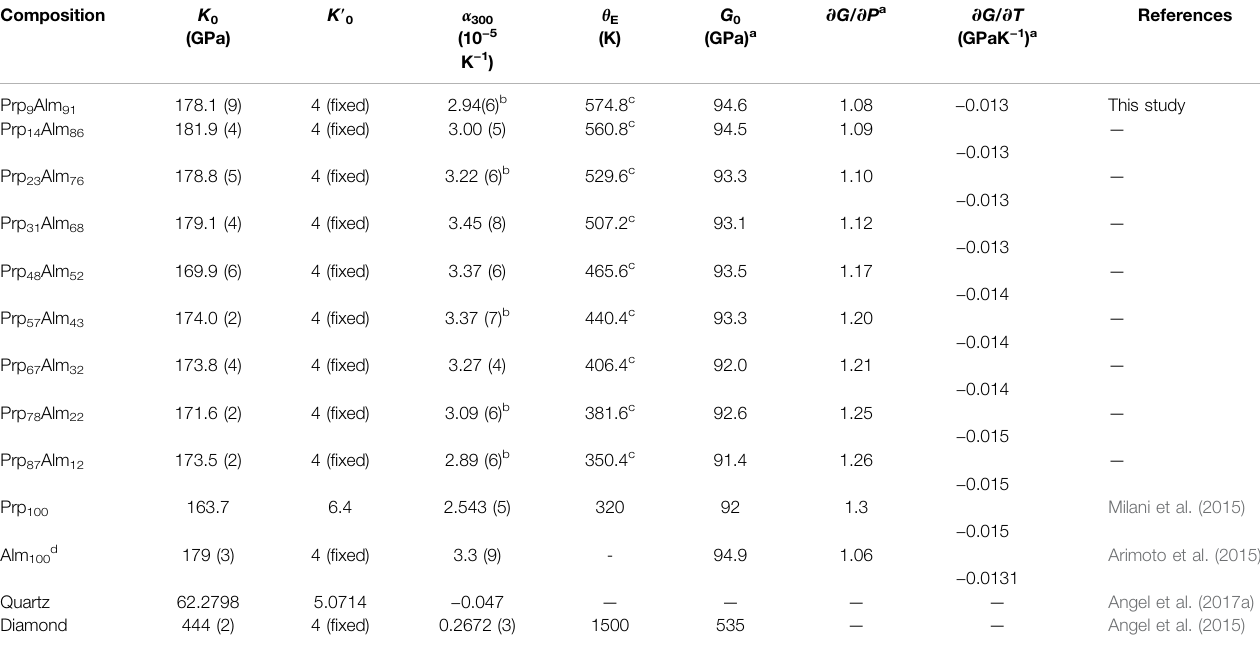
TABLE 3 | Room pressure – temperature EoS coef fi cients for selected minerals ( Prp-Alm garnets, diamond and quartz).